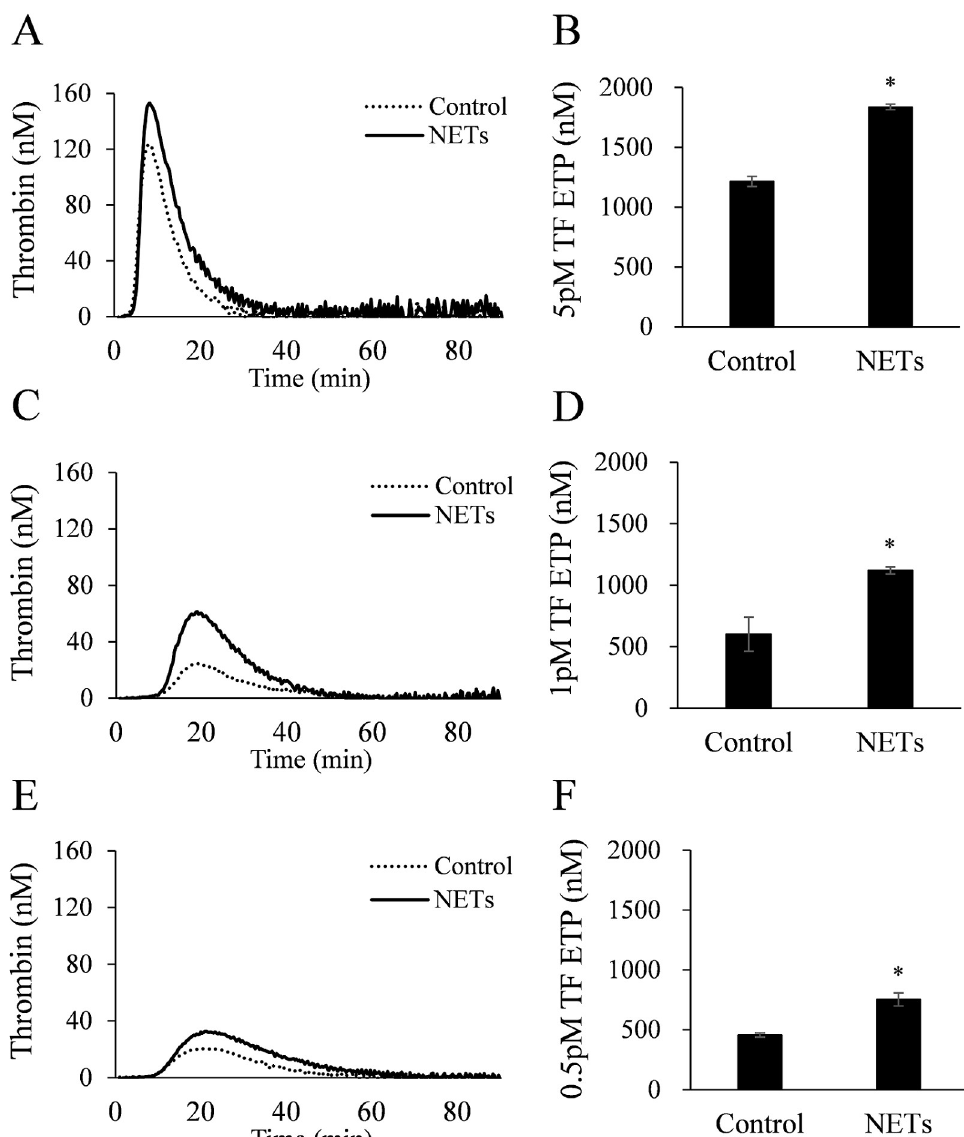
Fig 3. NETs increase thrombin generation in normal plasma. NETs were prepared from isolated neutrophils treated with PMA and added (6.4 mg/dL final protein level) to normal plasma. Endogenous thrombin potential (ETP) was measured by thrombin generation assay after stimulation with (5, 1, or 0.5 pM TF. All data are presented as mean ± SEM from 4 different experiments. � P < 0.05 versus control.